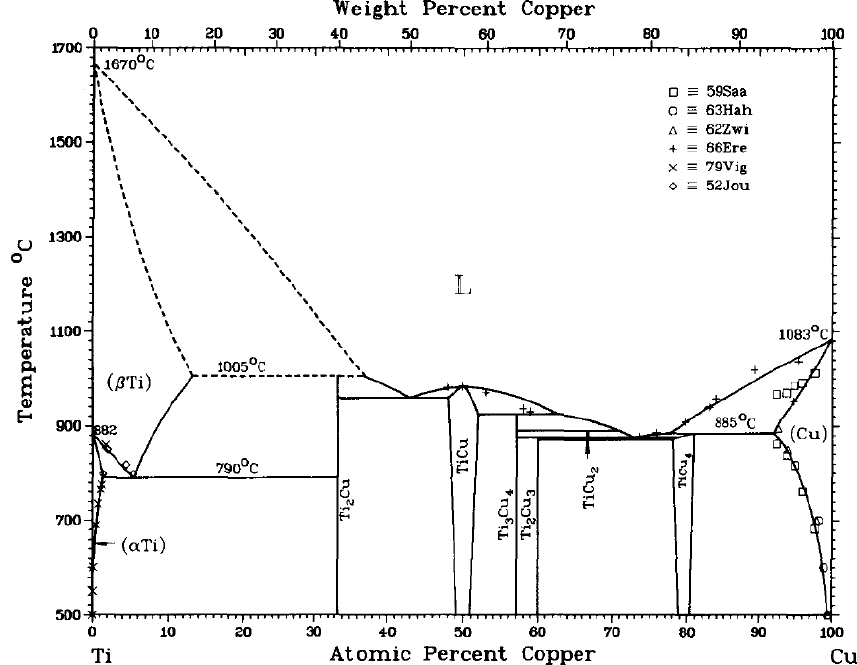
Figure 2. Phase diagram of the binary CuTi alloy [14]. Reproduced with permission from Bulletin of Alloy Phase Diagrams, Springer Nature, 1983.